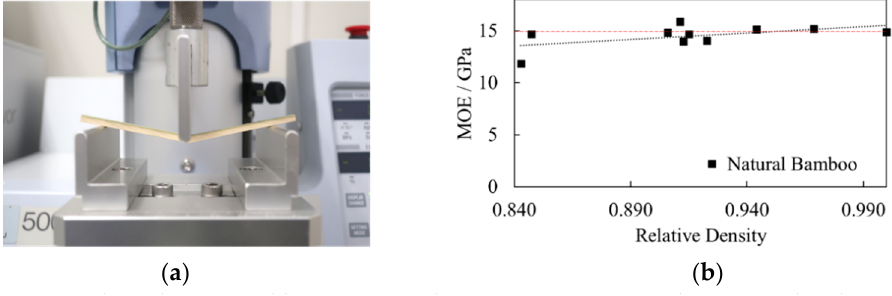
Figure 4. ( a ) Shimadzu EZ-S table-top universal testing instrument used in 3-point bending test; ( b ) 3-point bending test results of natural bamboo.